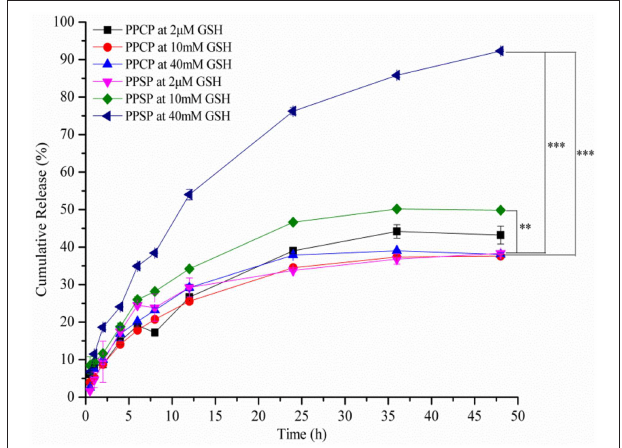
FIGURE 6 | Redox-sensitive release of drug from PPSP and PPCP micelles.